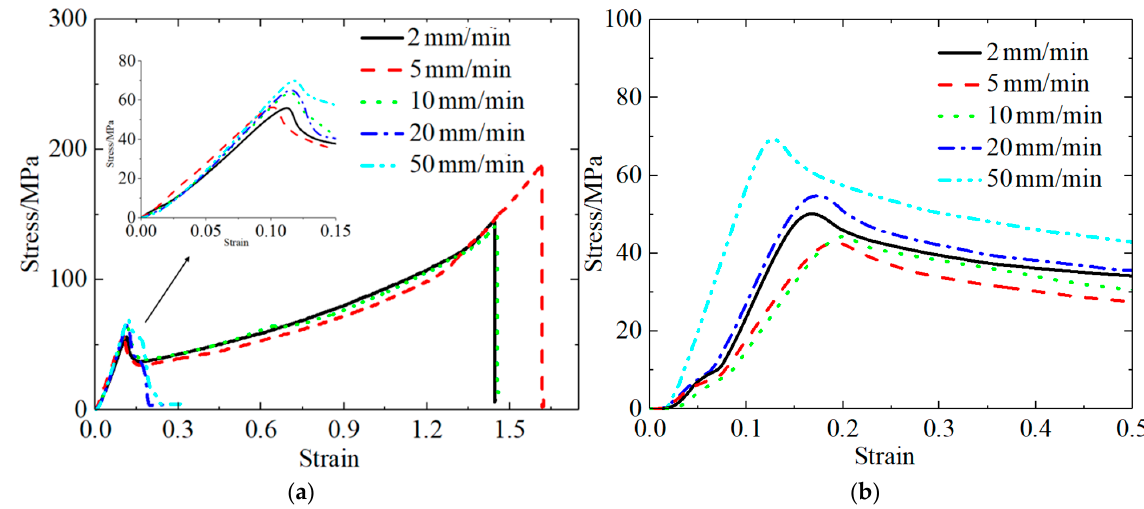
Figure 3. Quasi ‐ static stress ‐ strain curve of PLA material. ( a ) Tensile stress ‐ strain curve; ( b ) compression stress ‐ strain Figure 3. Quasi-static stress–strain curve of PLA material. ( a ) Tensile stress–strain curve; ( b ) compression stress–strain curve. curve. Table 5. PLA quasi-static tensile test data.